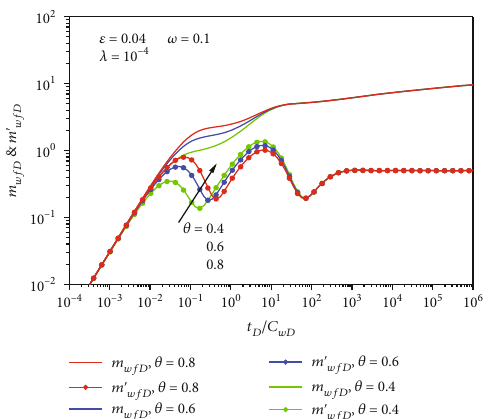
Figure 12: The in fl uence of storage ratio.